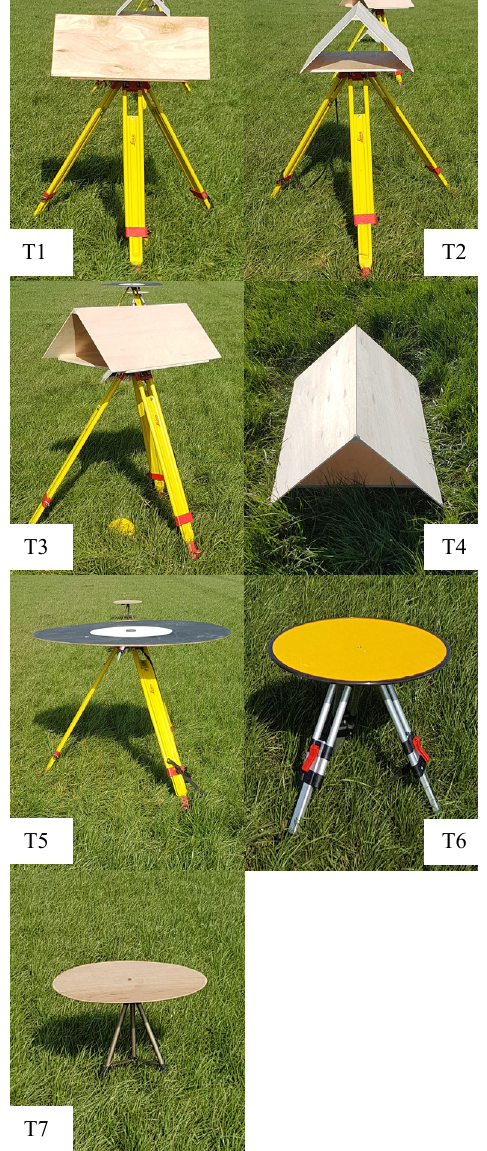
Figure 3. Targets T1 to T7 located in the survey area, looking north-east.